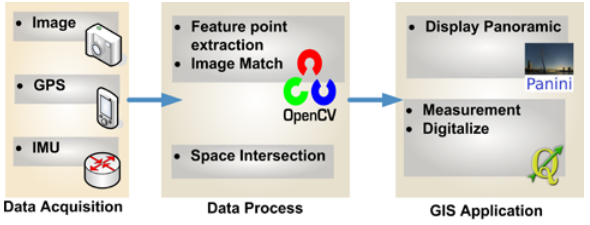
Figure 1. The system overall operation of the